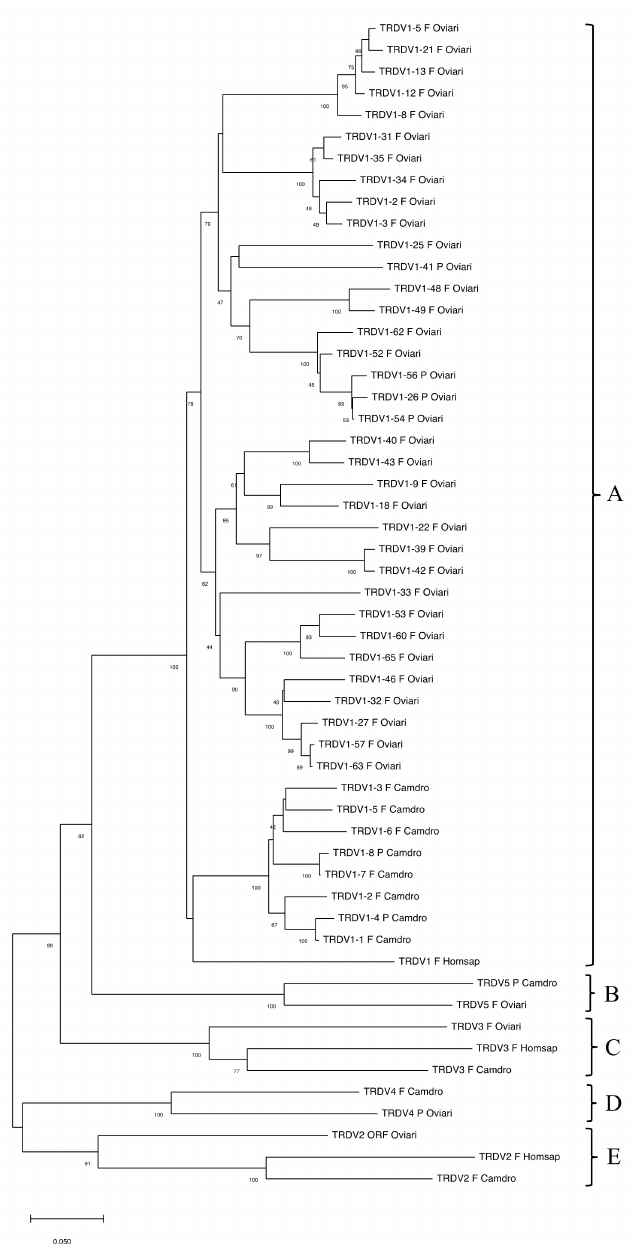
Figure 3. The NJ tree inferred from the dromedary, sheep and human TRDV gene sequences. The five groups (A–E) of the TRDV genes drawn by the tree are indicated by brackets. The evolutionary analyses were conducted in MEGA X [30,31]. The optimal tree with the sum of branch length = 4.03998833 is shown. The percentage of replicate trees in which the associated taxa clustered together in the bootstrap test (100 replicates) are shown below the branches [36]. The tree is drawn to scale, with branch lengths in the same units as those of the evolutionary distances used to infer the phylogenetic tree. The evolutionary distances were computed using the p-distance method [33] and are in the units of the number of base differences per site. This analysis involved 54 nucleotide sequences. Codon positions included were 1st + 2nd + 3rd + Noncoding. All ambiguous positions were removed for each sequence pair (pairwise deletion option). There was a total of 411 positions in the final dataset. The gene functionality according to IMGT rules (F: functional, ORF: open reading frame, P: pseudogene) is indicated. The IMGT 6-letter for species (Camdro, Oviari and Homsap) standardized abbreviation for taxon is